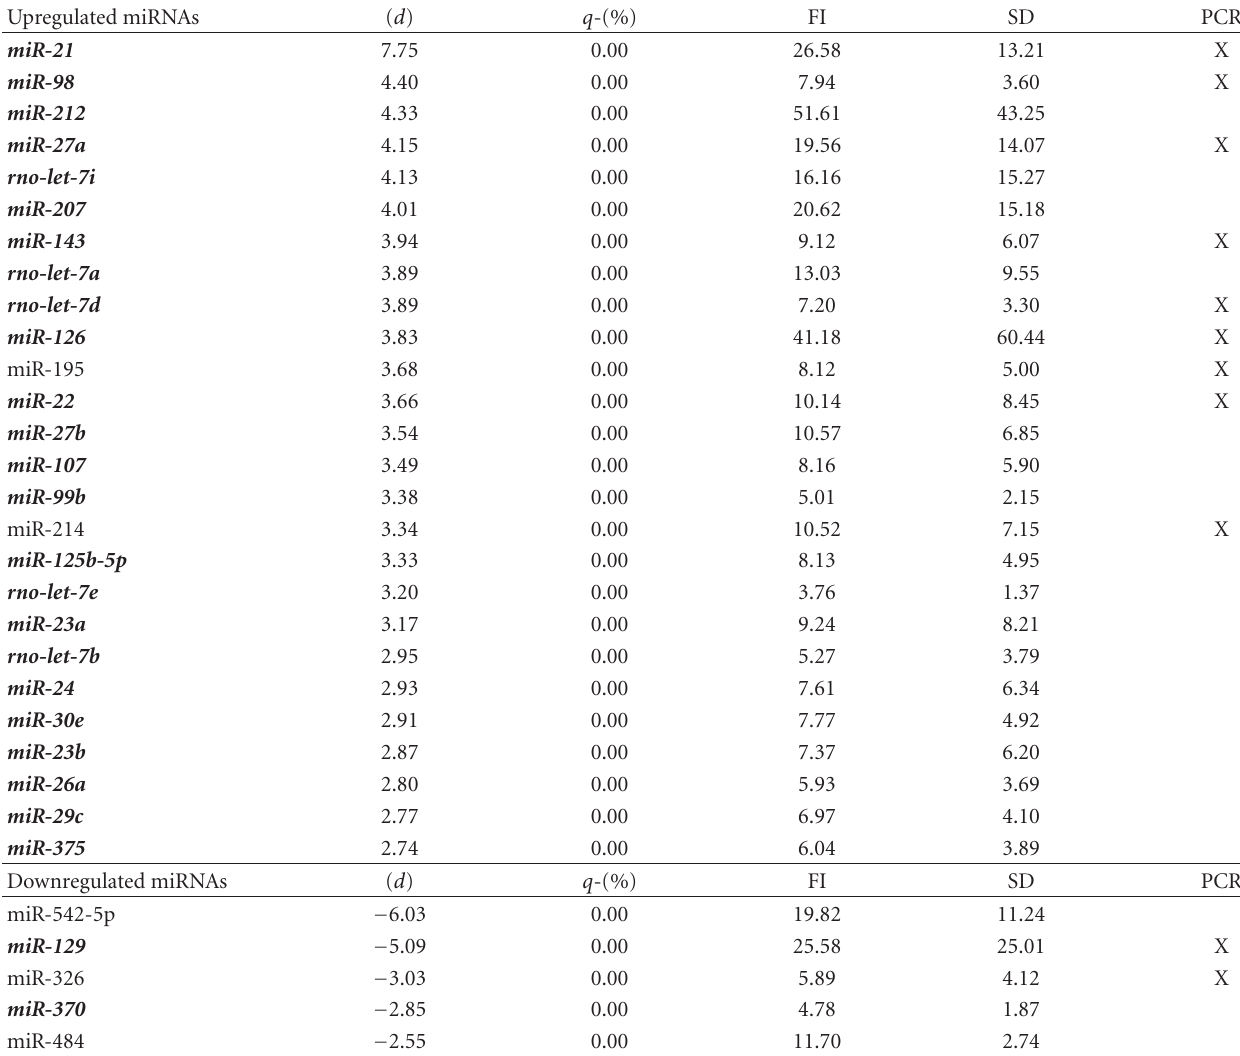
Table 3: SAM of miRNAs expressed in transplanted syngeneic islets collected 3 days after implantation. MiRNA expression in transplanted islets was compared to control isolated islets. 26 common miRNAs that displayed altered expression in vivo and in vitro (cytokine treated islets) are shown in bold font. MiRNA confirmed by PCR are marked with an X in the last column. FI and SD are fold increase and standard deviation of hybridization values (transplanted islets versus control islets),